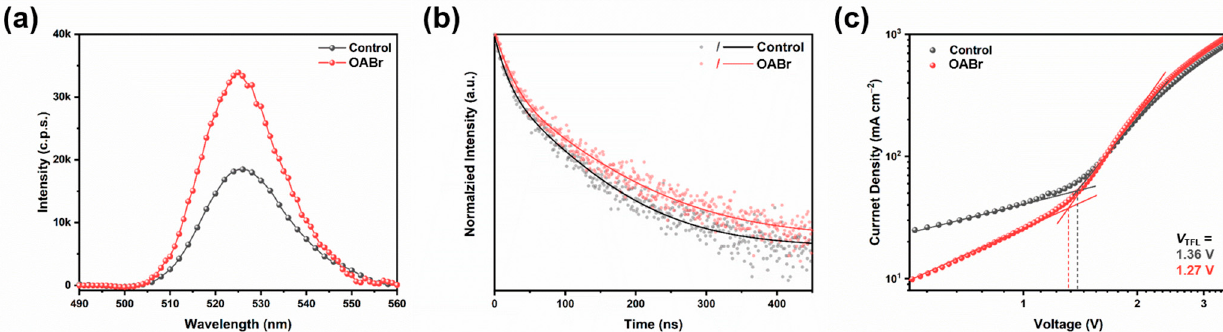
Figure 3. ( a ) Steady-state and ( b ) time-resolved PL measurements for CsPbBr 3 films before and after OABr surface treatment. Dots in time-resolved PL measurement represent the experimental data and lines are the fitted data. ( c ) SCLC measurement of electron-only device with architecture of FTO/TiO 2 /CsPbBr 3 /PCBM/Ag.